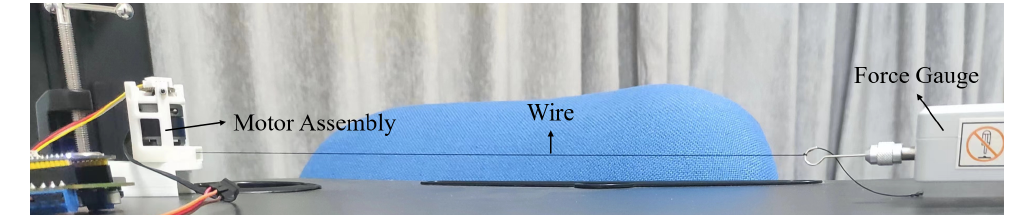
Figure 11. Experimental setup to determine the relationship between the current limit and feed- back